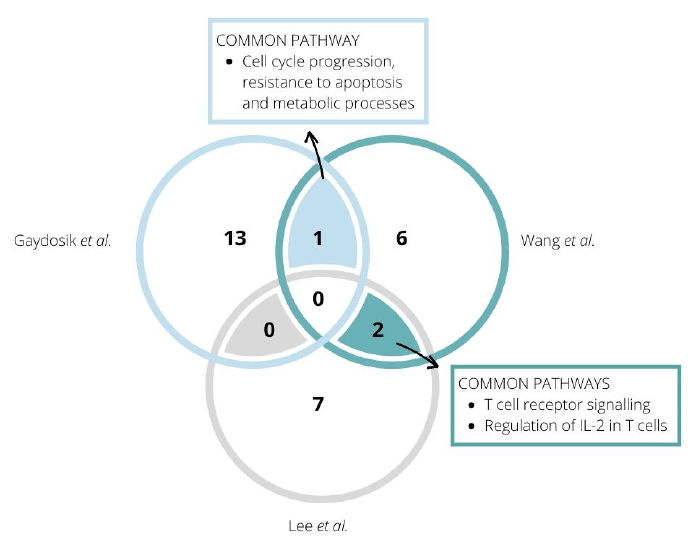
Figure 2. Unique and shared deregulated signaling pathways in Cutaneous T-cell lymphoma (CTCL) cells identified by high-throughput sequencing in the studies by Gaydosik et al., Wang et al. and Lee et al.